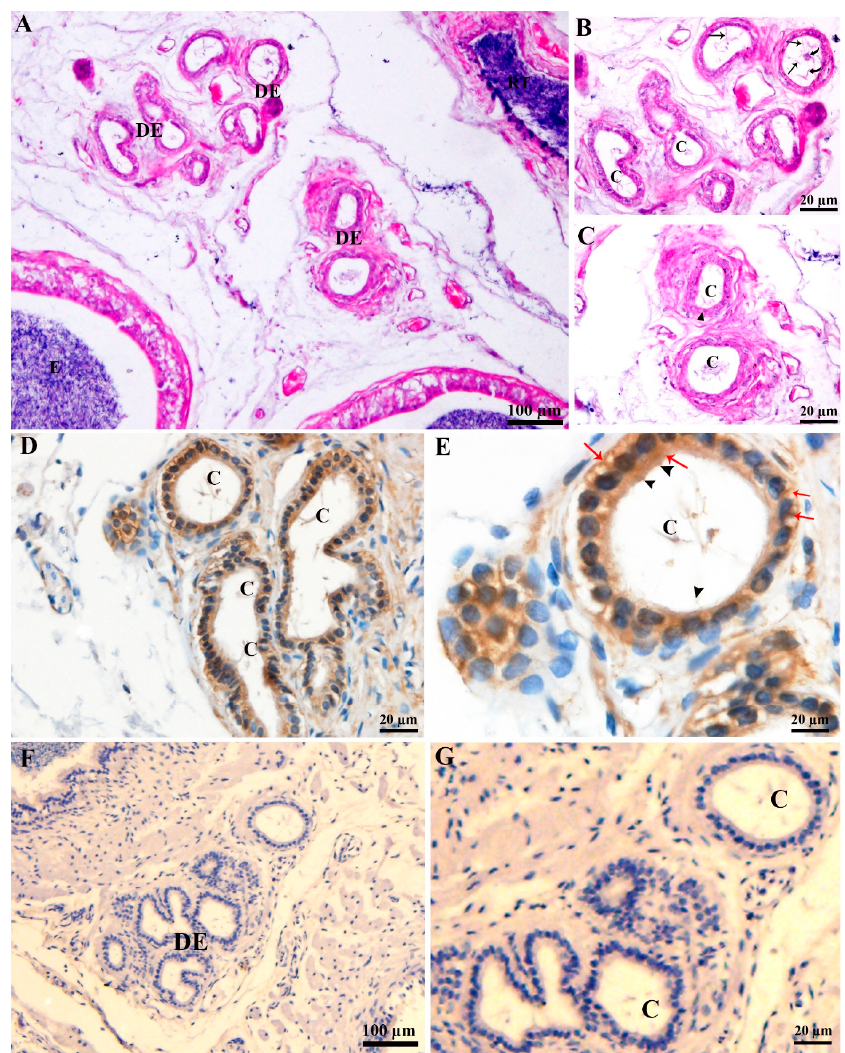
Figure 1. Light microscopy of ductuli efferentes. (A) Ductuli efferentes: a passage from rete testis to epididymis. (B–C) Cilia: a long protruding meshwork (black arrow) from ciliated cells with sperm (curved arrow) in the lumen of ductuli efferentes. (D–E) CD63 Immunohistochemistry (Redarrow